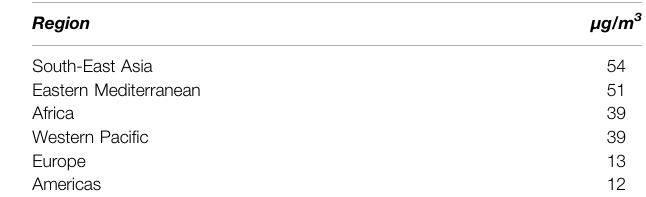
TABLE 1 | Annual mean concentration of fi ne particulate matter PM 2.5 by region, population-weighted (Indicator 11.6.2), for the year 2016 (World Health Organization,